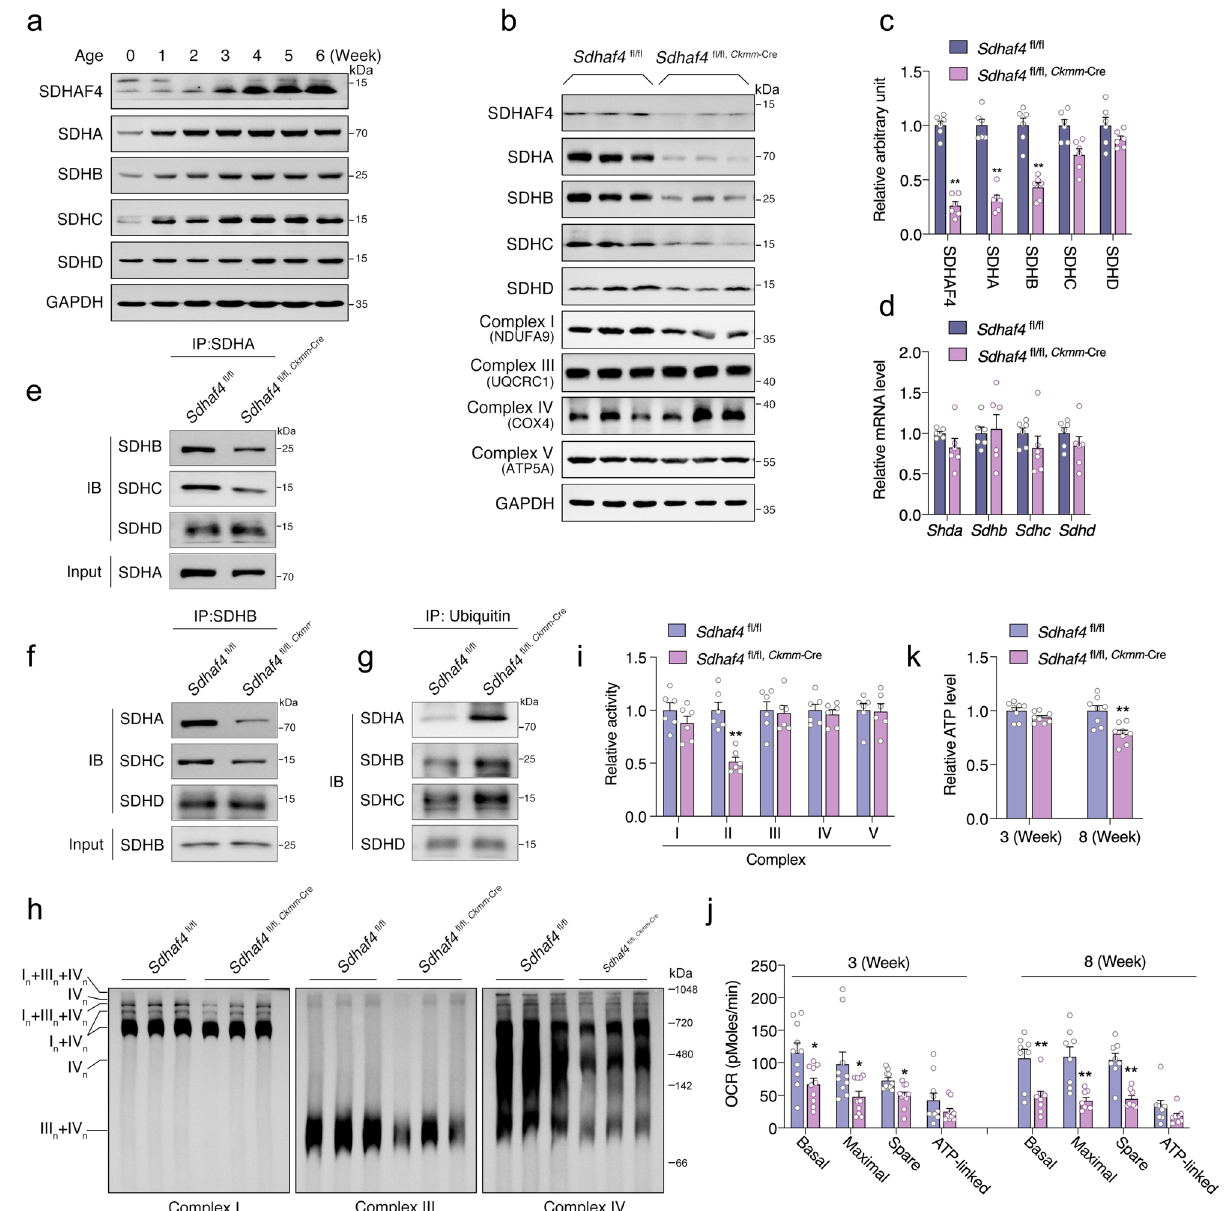
Fig. 4 Loss of SDHAF4 disrupts complex II assembly and promotes mitochondrial dysfunction. a Immunoblots for SDHAF4 and complex II subunits in left ventricles of WT mice at different ages. b , c Immunoblots for SDHAF4 and mitochondrial complex subunits in left ventricles of hearts from WT and Sdhaf4 mutant mice at age of 3 weeks ( b , representative blotting image; c , summary analysis of arbitrary unit, n = 6, P <0.0001). d mRNA levels of Sdha , Sdhb , Sdhc , and Sdhd in left ventricles of hearts from WT and Sdhaf4 mutant mice ( n = 6). e Coimmunoprecipitation of SDHB, SDHC, and SDHD with SDHA from the lysates of left ventricles of hearts from WT and Sdhaf4 mutant mice at age of 3 weeks. f Coimmunoprecipitation of SDHA, SDHC, and SDHD with SDHB from the lysates of left ventricles of hearts from WT and Sdhaf4 mutant mice at age of 3 weeks. g Coimmunoprecipitation of SDHA, SDHB, SDHC, and SDHD with Ubiquitin from the lysates of left ventricles of hearts from WT and Sdhaf4 mutant mice at age of 3 weeks. h Immunoblots for mitochondrial supercomplex: mitochondrial proteins of left ventricles of hearts from WT and Sdhaf4 mutant mice were subjected to BN-PAGE and immunoblot with NDUFA9 (subunit of Complex I), UQCRC1 (subunit of Complex III), and COX4 (subunit of complex IV) antibodies. i , Analysis of complex activities of mitochondrion from left ventricles of hearts from WT and Sdhaf4 mutant mice at age of 3 weeks, n = 6, P = 0.0002. j – k Mitochondrial oxygen consumption rate (OCR, P = 0.013, 0.026, 0.015, 0.003, 0.001, 0.00013) and ATP level of left ventricles of hearts ( P = 0.002) from WT and Sdhaf4 mutant mice at age of 3 and 8 weeks, n = 9. Values are mean±SEM, * P <0.05, ** P <0.01. Statistical signi fi cance was determined by two-tailed Student ’ s t -test ( c , d , i – k ). Source data are provided in Source Data fi